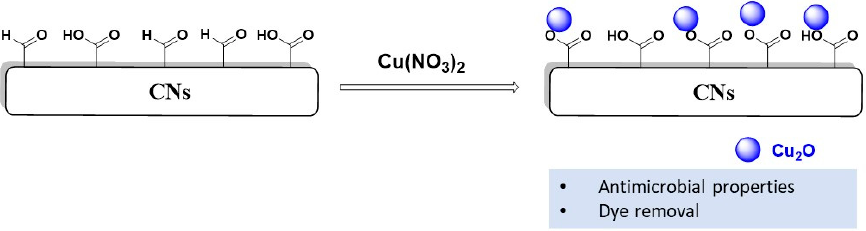
Figure 5. Conceptual scheme showing the in-situ formation of Cu 2 O nanoparticles on CNs films